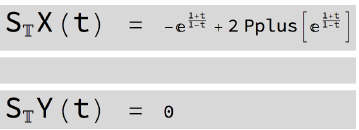
Figure 68. Output given by the [SInt] 2.0